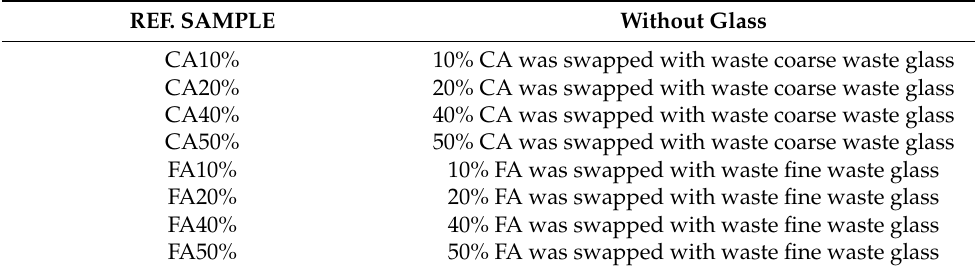
Table 1. Different mixtures of the concrete with recycled glass. REF. SAMPLE